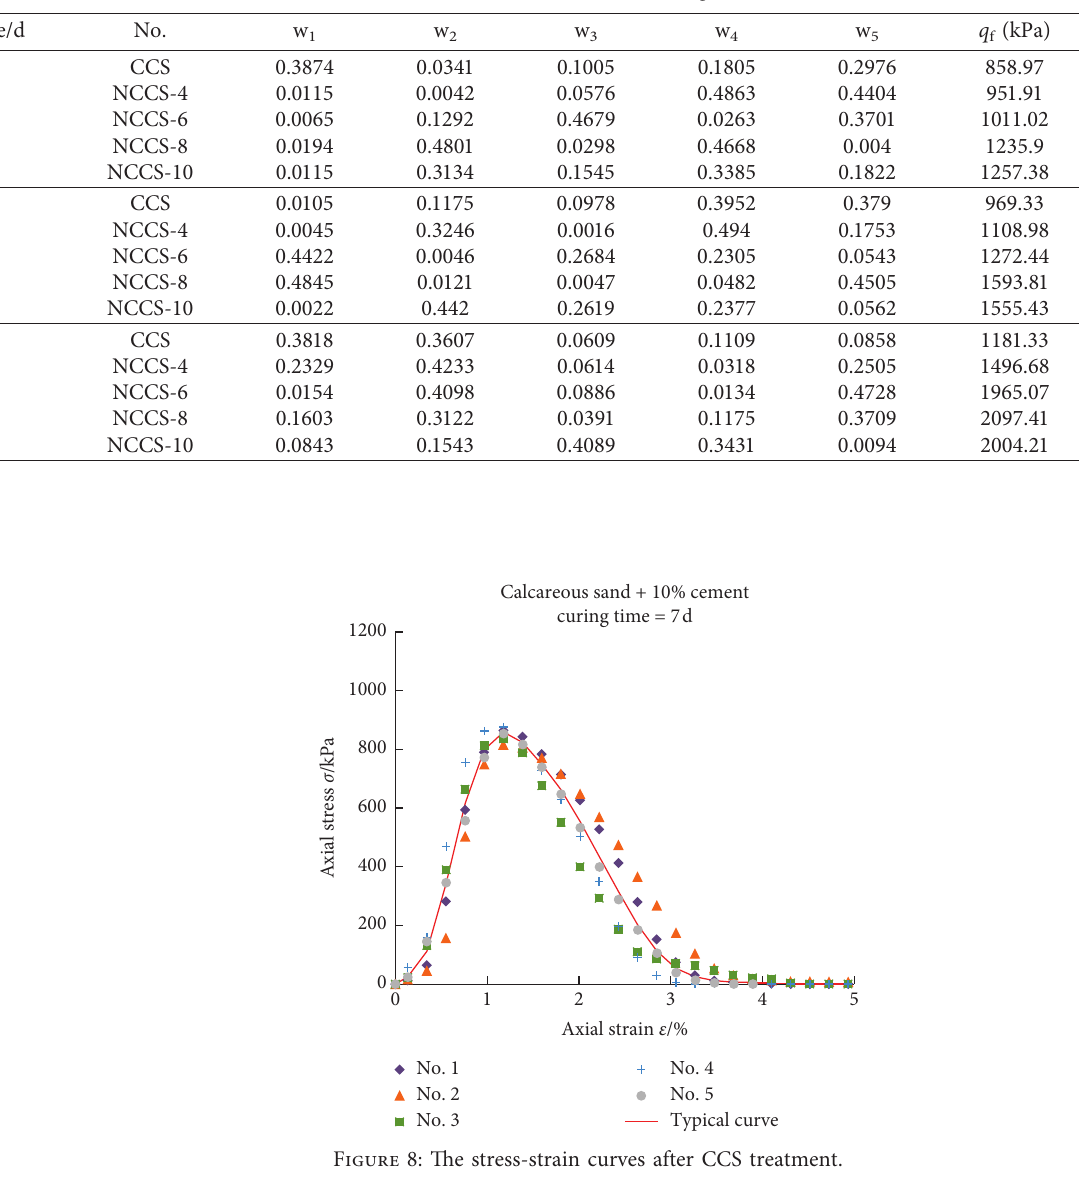
Table 5: The results of fusion algorithm.